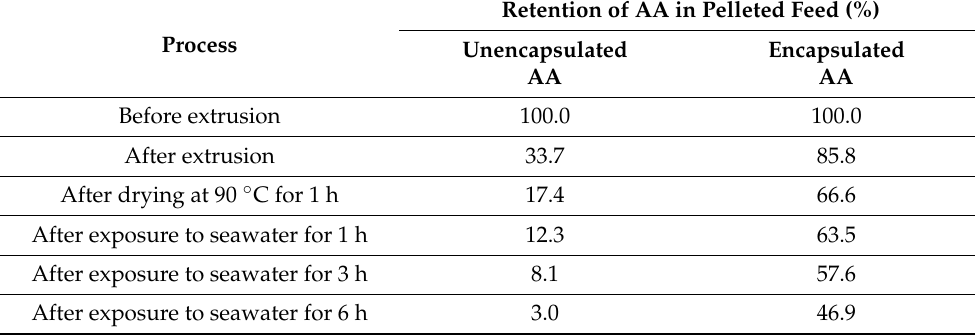
Table 3. Retention of AA in pelleted feed at each step of feed processing and during 6-h of the exposure to seawater.